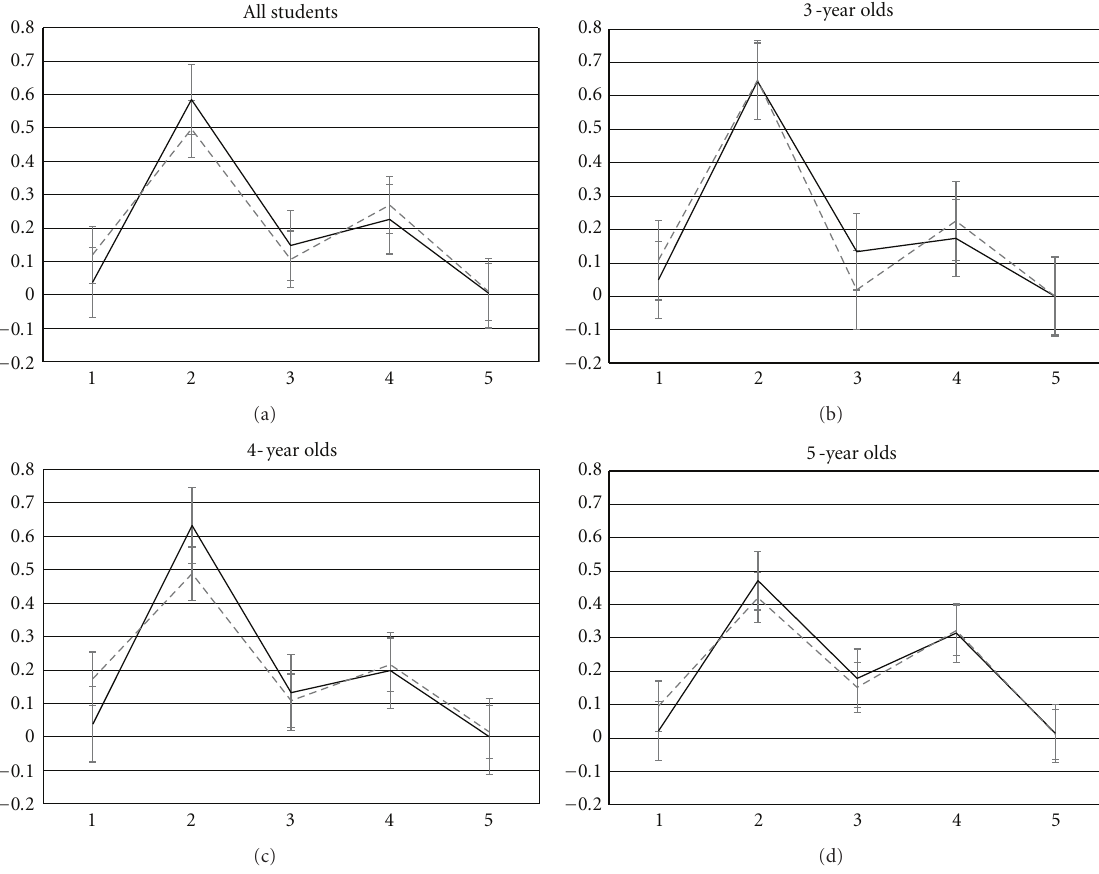
Figure 3: The proportion ( Y -axis) of the answer levels 1–5 ( X -axis) for all students, and the 3 age groups. Regular students are displayed by the solid line, SN students by the dashed